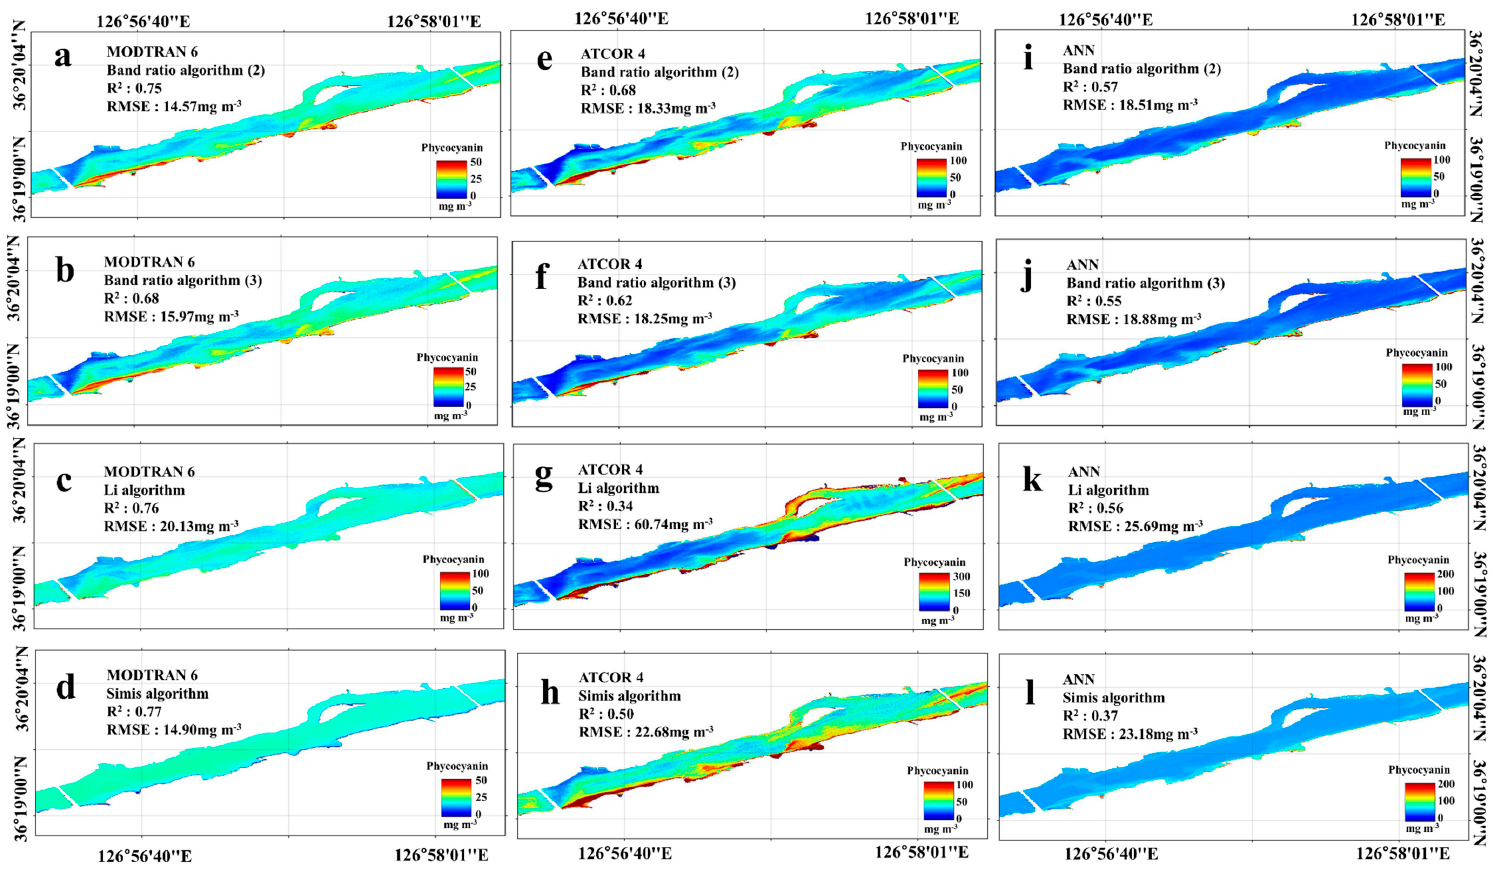
Figure 9. Phycocyanin (PC) concentration images on 24 August 2016 in Section 1. Panels ( a – d ) show the PC distribution driven by the MODTRAN 6 atmospheric correction. Panels ( e – h ) show the PC distribution driven by the ATCOR 4 atmospheric correction. Panels ( i – l ) show the PC distribution driven by the ANN atmospheric correction.